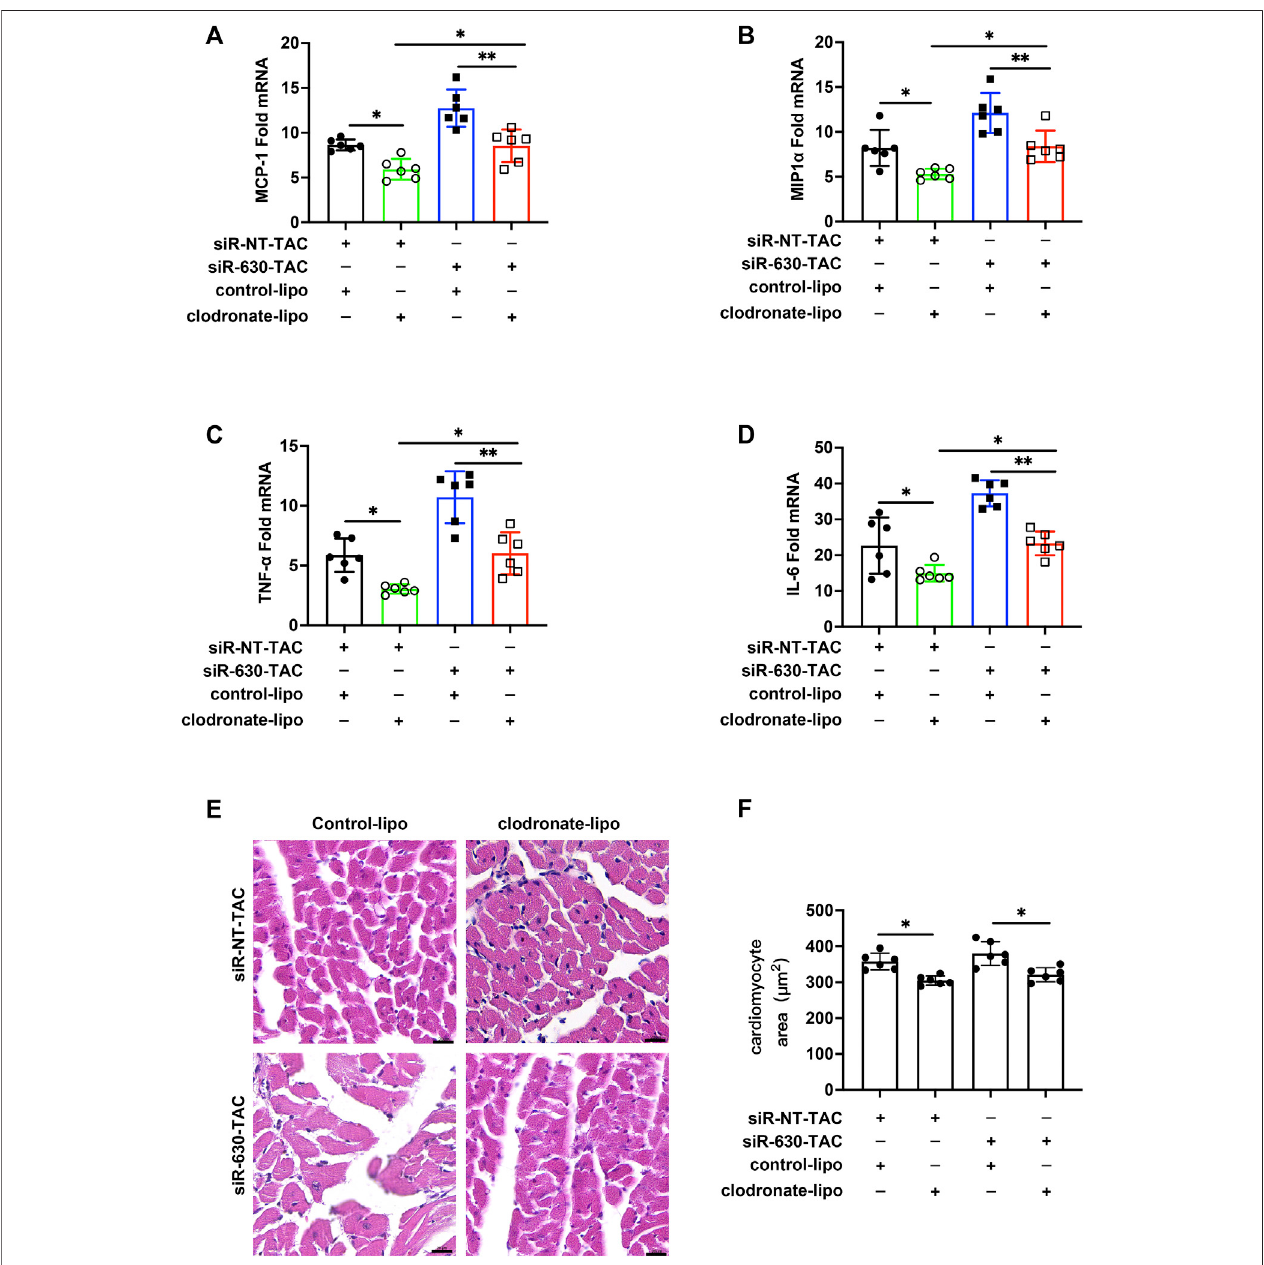
FIGURE 3 | Depletion of macrophages mitigated in fl ammation and cardiac remodeling in EGFL7 KD mice. C57BL/6J mice were subjected to either sham or TAC operation, then clodronate liposomes or clodronate control was tail vein injected every other day from the second-day post-TAC for 4 weeks. siRNA-NT or siRNA-630 was intraperitoneal injection twice a week from the second-day post-TAC for 4 weeks. Morphological measure observed at 4 weeks. ( n = 6 in each group). (A) Expression of in fl ammatory cytokine mRNA including MCP-1, MIP1 α (B) , TNF- α (C) , and IL-6 (D) in heart tissue of TAC mice treated with clodronate liposomes or control (* p < 0.05, ** p < 0.01 by one-way ANOVA followed by Tukey ’ s test). (E, F) Representative hematoxylin-eosin staining indicated cardiomyocytes cross-sectional area. The quantitative analysis of the cardiomyocyte area was calculated using ImageJ software (* p < 0.05 by one-way ANOVA followed by Tukey ’ s test). Scale bar = 20 μ m. All data represent the mean ± SD from at least 4 independent